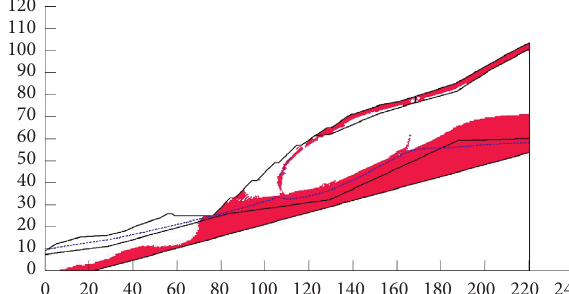
Figure 14: Plastic zone distribution of the cracking slope with permeability ratio as 1.0 after